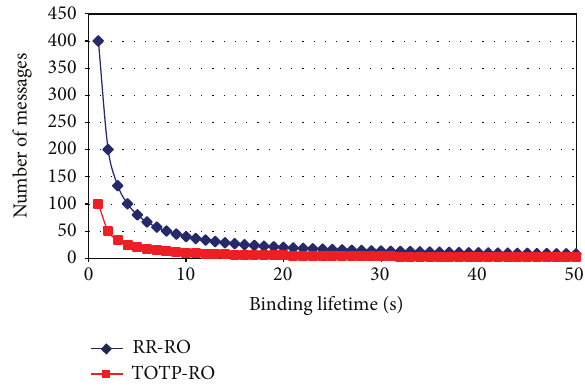
Figure 14: Number of messages exchanged due to binding lifetime expiry.